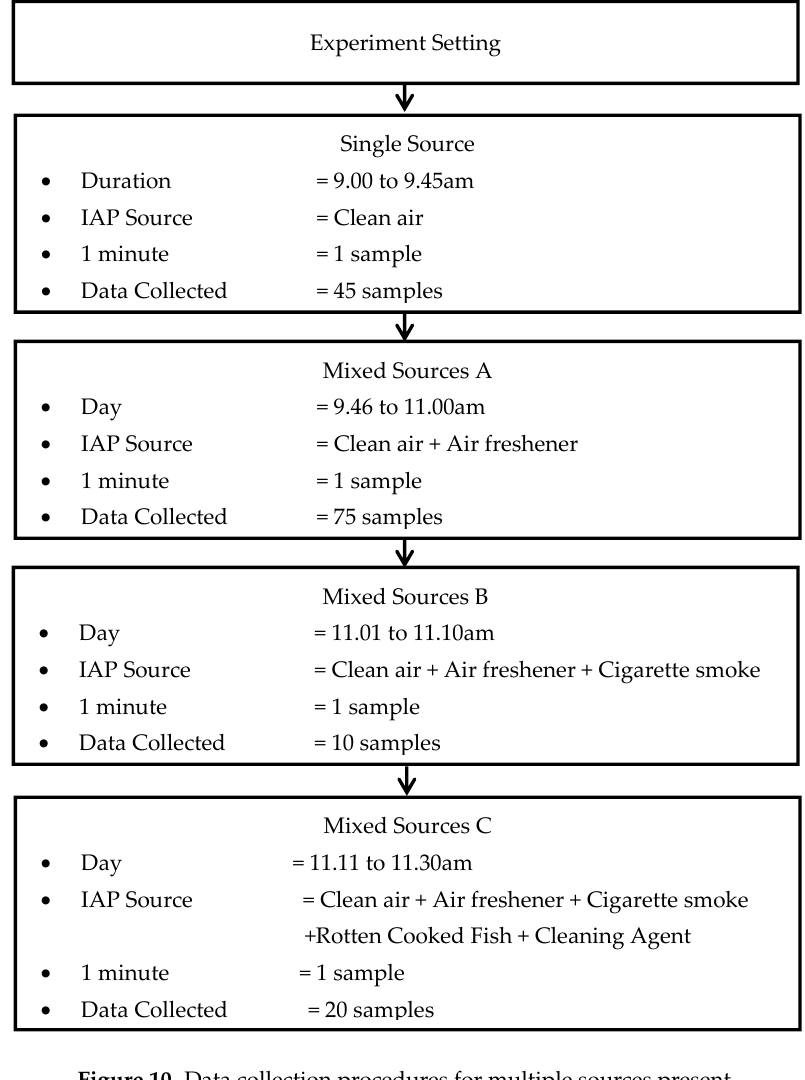
Figure 10. Data collection procedures for multiple sources present.